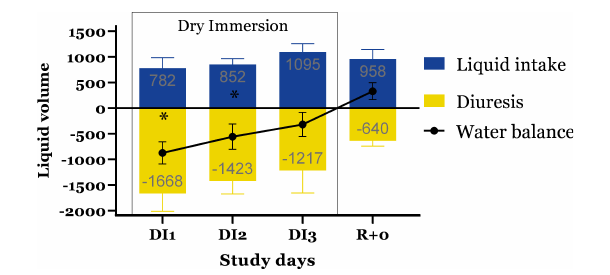
FIGURE 4 | Daily volume of consumed and discharged fluid, as well as the water balance. Mean ± SEM. * < 0.05 vs. R +